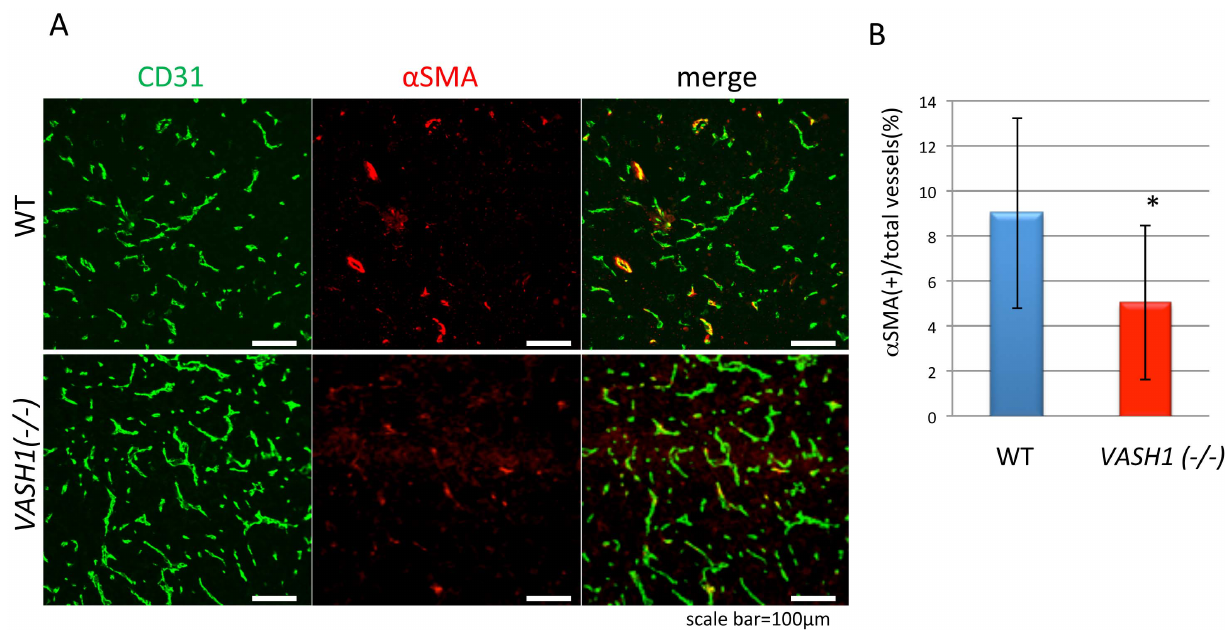
Figure 6. Composition of tumor vessels with respect to ECs and mural cells. A: Tumor sections from the legs of WT and VASH1 ( 2 / 2 ) mice were immunostained for CD31 and a SMA. Bar=100 m m. B: Ratio of a SMA-positive vessels to total vessels is shown (N=7). *p , 0.05.